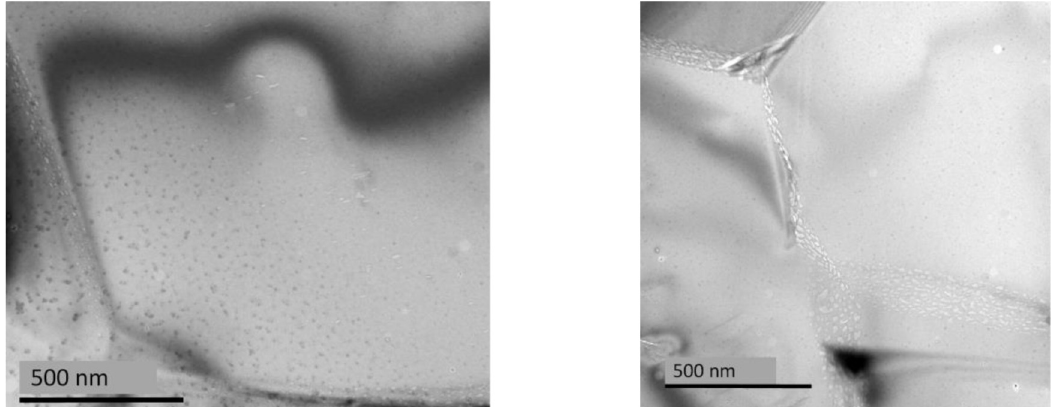
Fig. 12. 4 He implanted in B 4 C and annealed at 1300 ° C. Left: intra-granular plate-like bubbles and inter-granular bubbles (bubbles appear in white; the black spots are artefacts due to FIB preparation). Right: inter-granular bubbles (two triple points).